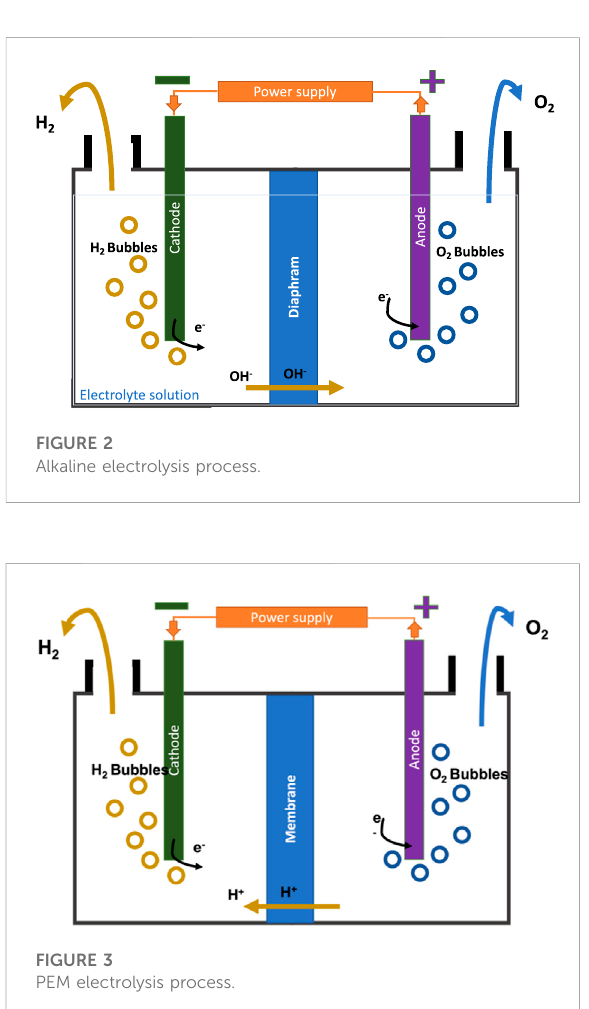
FIGURE 3 PEM electrolysis